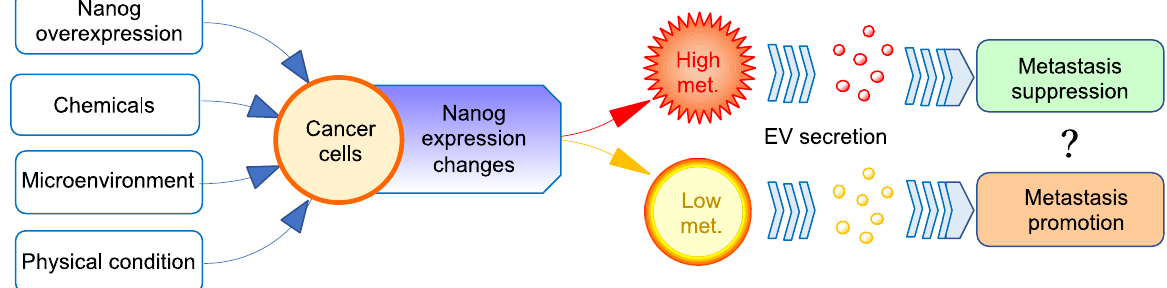
Figure 1. Paradoxical effects of EVs from Nanog -overexpressing cancer cells on their metastasis. Nanog expression level in cancer cells can be changed by genetic, chemical, microenvironmental, or physical factors. The higher the Nanog expression level, the higher the metastatic potential. The role of EVs in cancer metastasis has been thought to follow the metastatic potential of cancer cells, that is, EVs derived from metastatic cancer cells exhibit metastasis-promoting effects. However, in the case of cancer cells with a very high metastatic potential, contrary to our expectations, EVs may promote cancer metastasis.